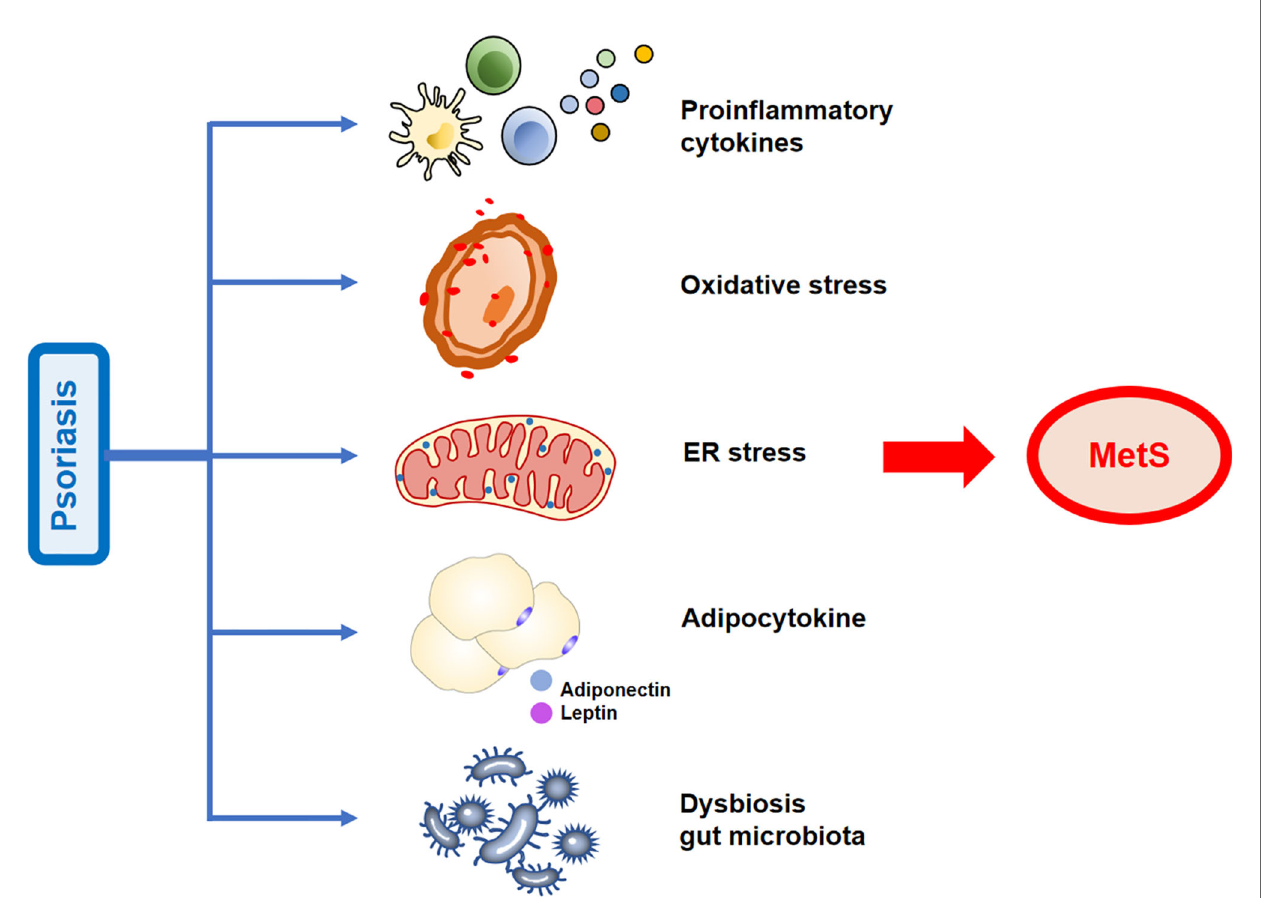
FIGURE 2 | Possible mechanisms linking psoriasis and metabolic syndrome (MetS). The increased release of pro-in fl ammatory cytokines, adipose tissue secretory adipocytokines, activation of oxidative stress states, increased endoplasmic reticulum (ER) stress, and gut microbiota dysbiosis observed in psoriasis contribute to the development of